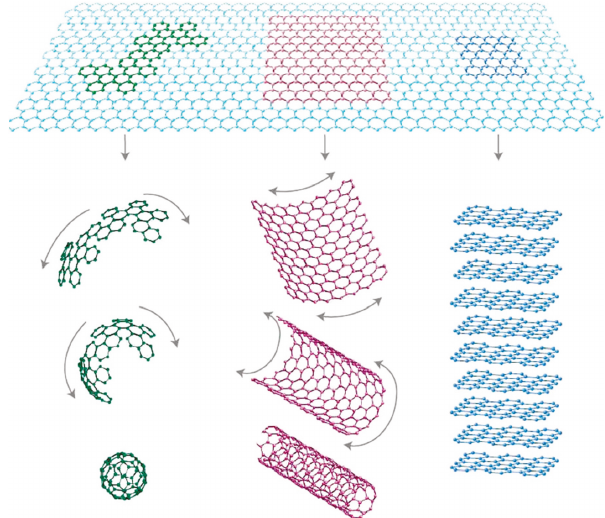
Figure 2: Graphene (top) and related structure: fullerene (bottom left), carbon nanotubes (bottom center), and graphite (bottom right)